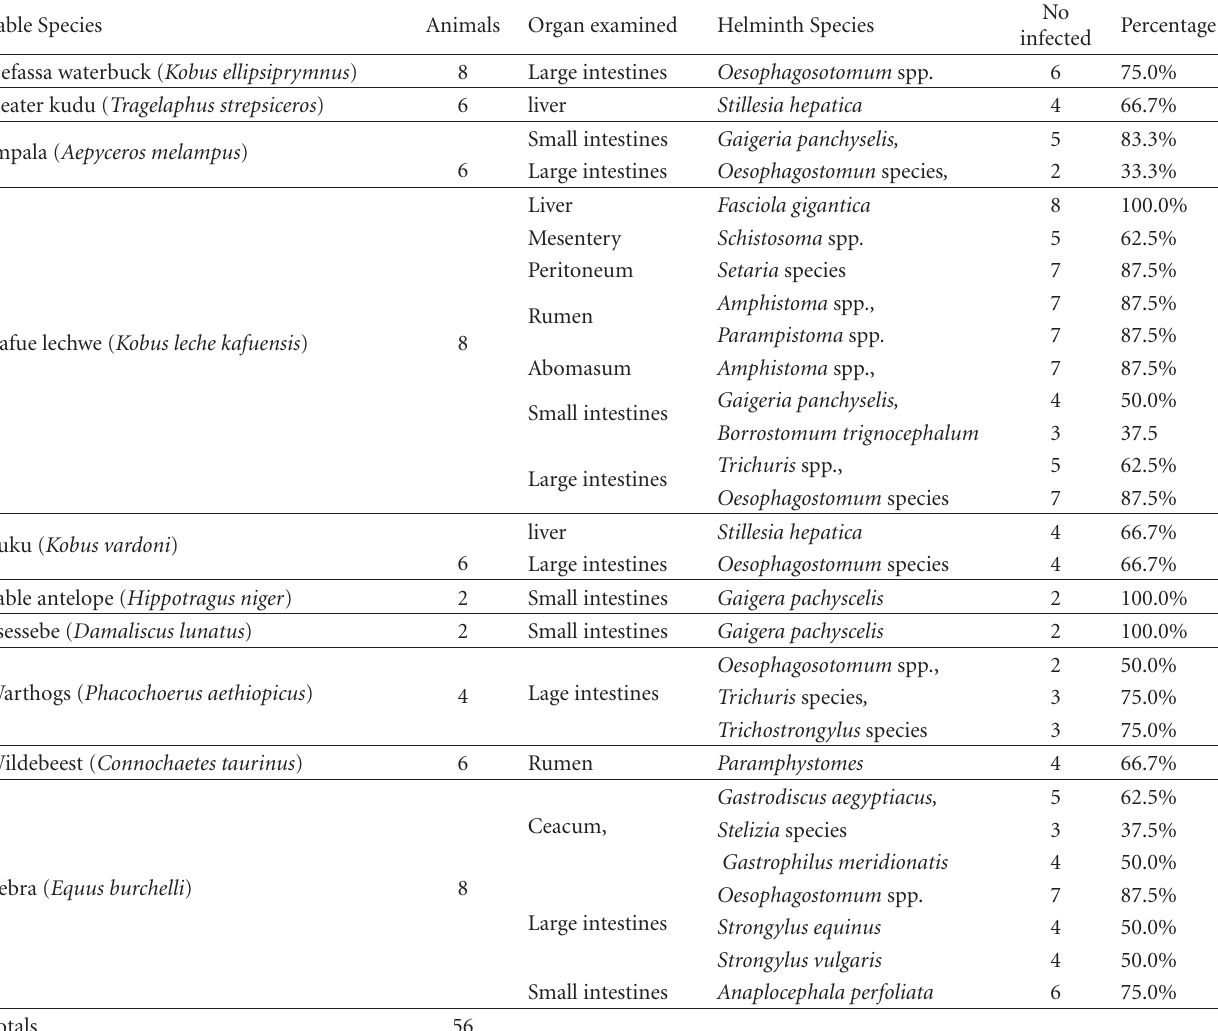
Table 4: Helminthes isolated from di ff erent wildlife